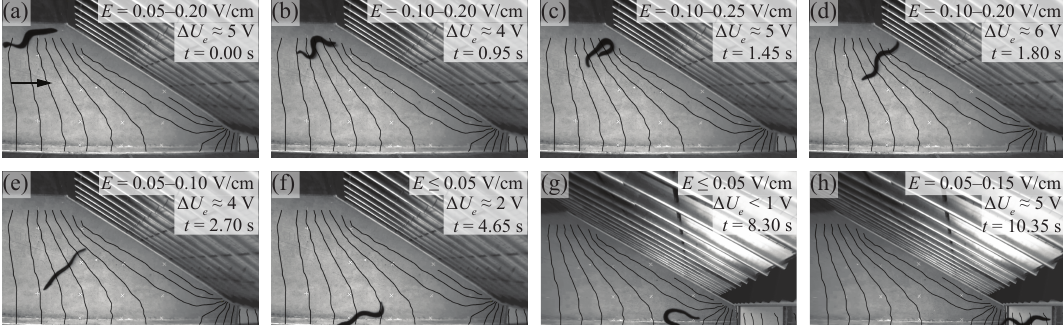
Figure 8. Typical behavior of an eel ( Anguilla anguilla ) with TL = 67 cm at the e-HBR with s b = 51 mm and U e = 38 V, which was guided towards the glass wall and subsequently into the bypass; the equipotential lines are visualized in black. The approximate voltage gradient E at the position of the eel, the body voltage ∆ U e and the timeline are given in the top right